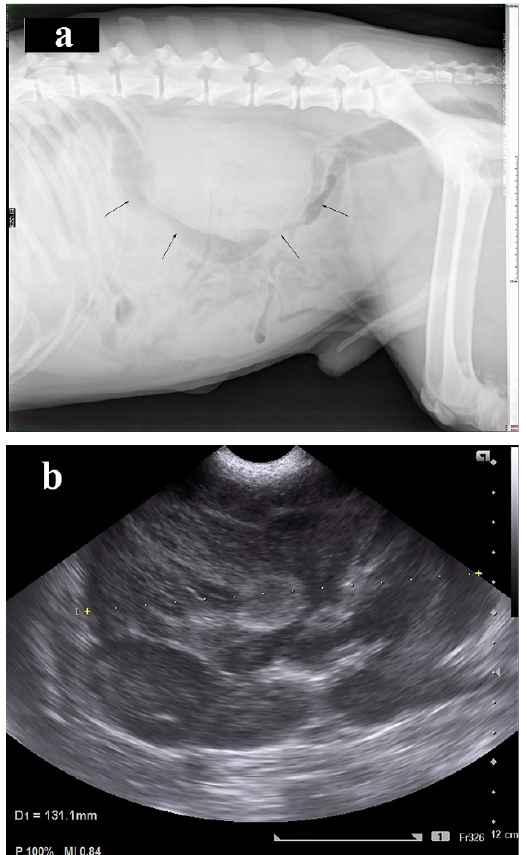
Figure 1. ( a ). Right lateral abdominal radiograph of a dog with renal lymphoma. Enlargement of the kidneys (arrows) with reduced serosal detail is indicated while lumbar and mesenteric lymph nodes cannot be depicted. ( b ). Ultrasound examination of the kidney of a dog with renal lymphoma. The presence of renal masses alters the normal architecture of the kidney and there is loss of corticomedullary demarcation. (+): symbolizes renal length measurement.